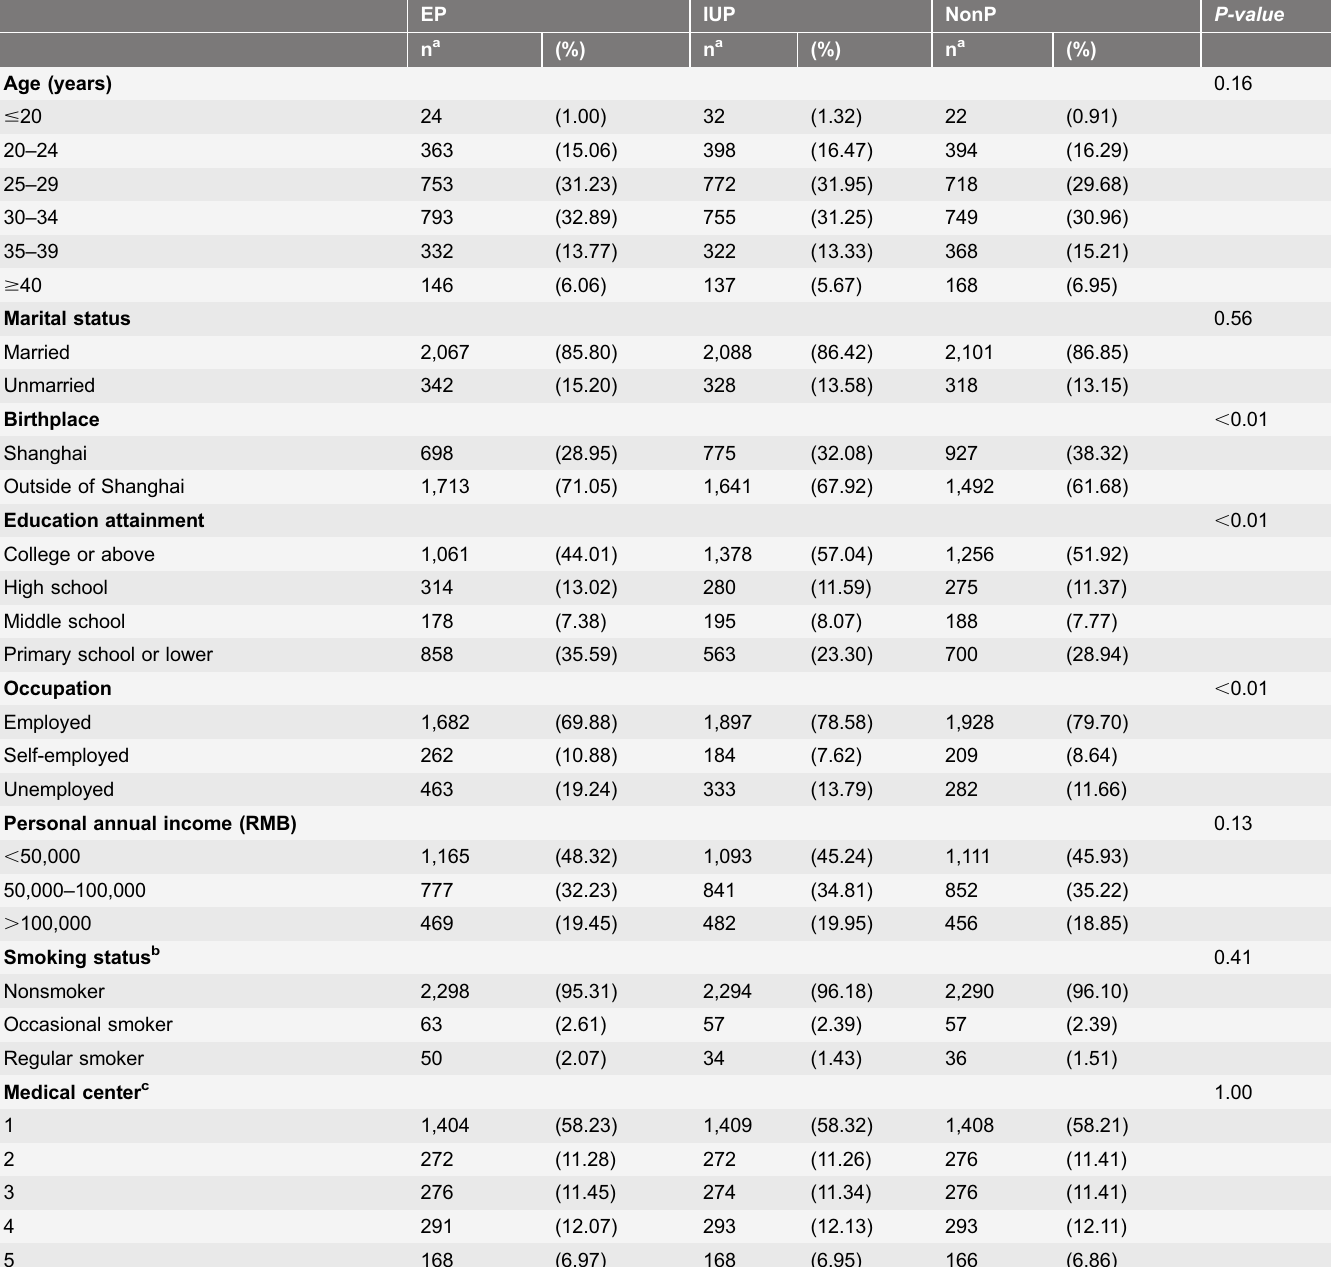
Table 1. Baseline characteristics (socio-demographic